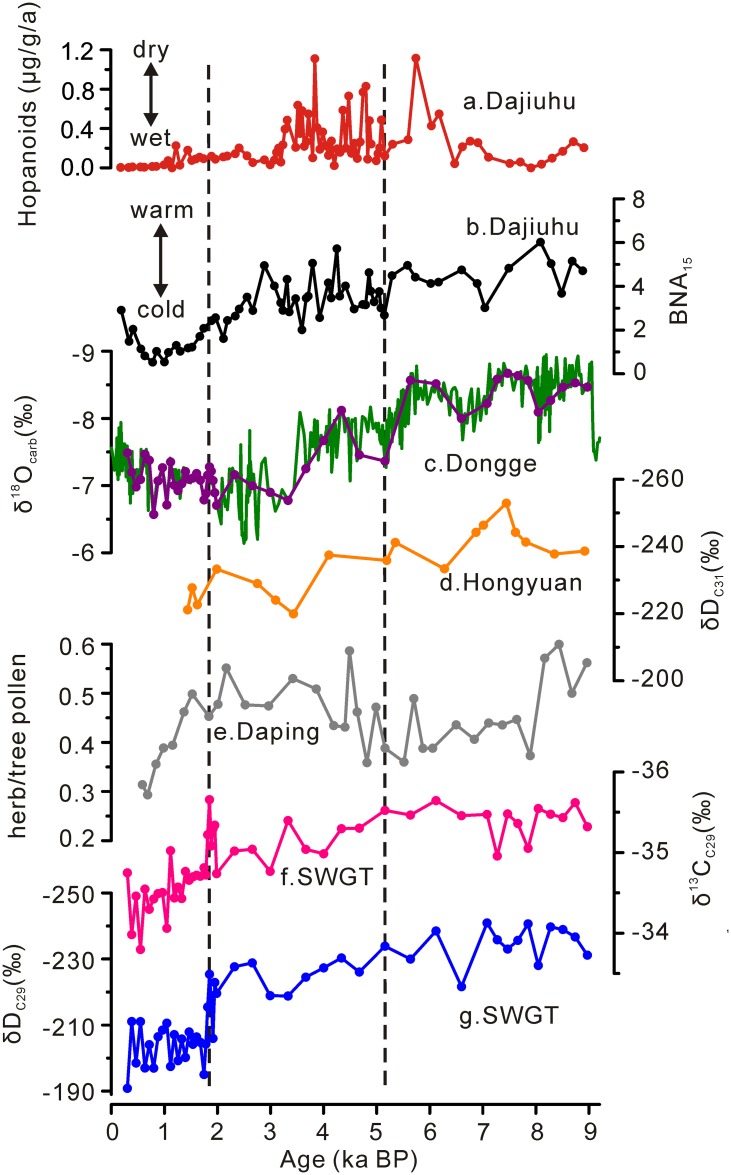
Comparisons of records.(a) Mass accumulation rate of hopanoids in the Dajiuhu peatland [26]. (b) BNA15 record from the Dajiuhu peatland[24], (c) δ18Ocarb record from Dongge Cave [30], (d) δDC31 record from the Hongyuan peat sequence [19], (e) ratios of total herb pollen over total tree pollen from the Daping sedimentary sequence [29], (f) δ13C C29 record (this study) and (g) δDC29 record (this study).